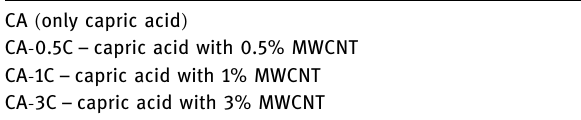
Table 3: Description of